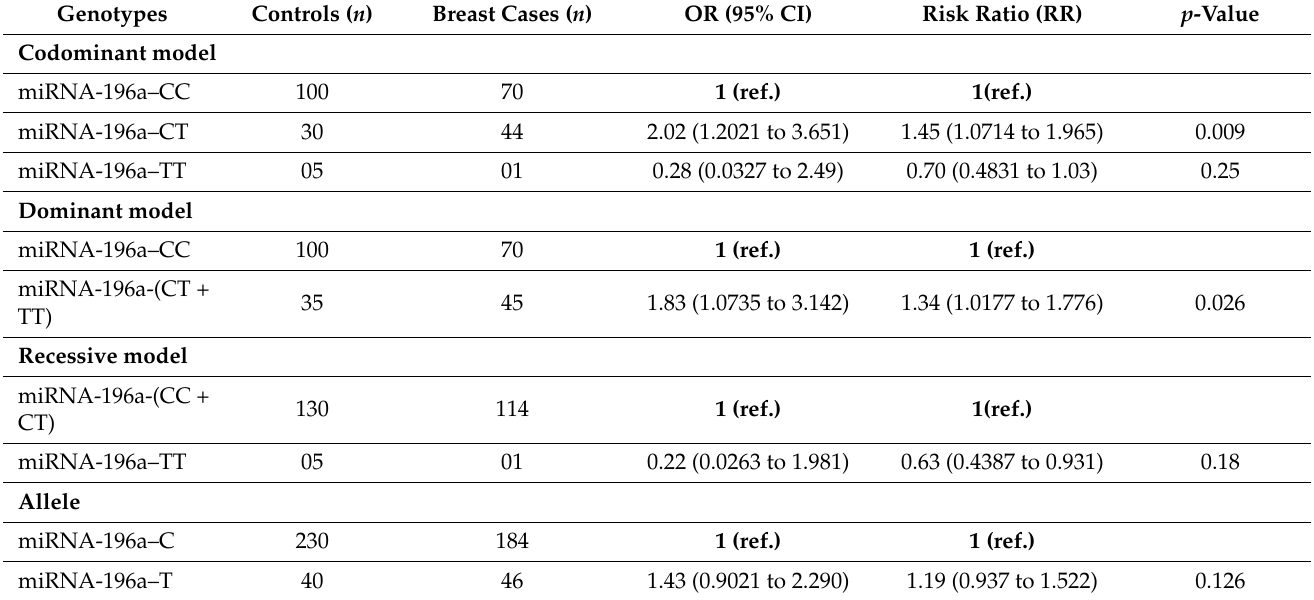
Table 9. Estimating the correlation between the miR-196aC > T genotypes and risk of breast cancer